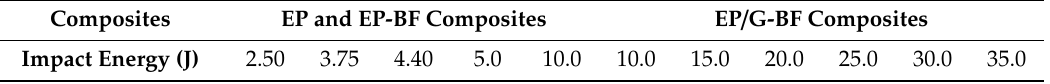
Table 2. Di ff erent impact energies applied on the EP, EP-BF composites and EP / G-BF composites.